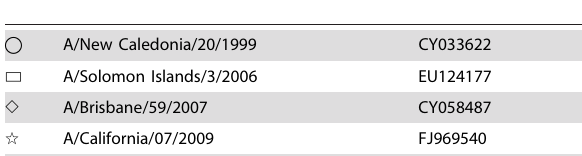
Table 1. Symbols legend for Fig. 2. Table 2. Symbols legend for Fig.